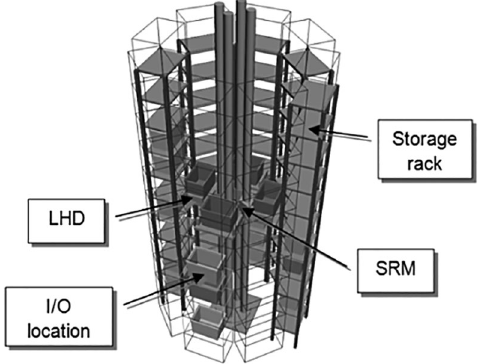
Fig. 1. C-AS/RS design